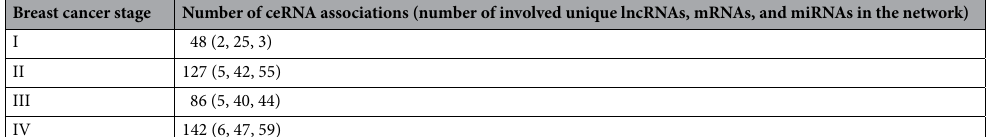
Table 2. The lncRNA-associated ceRNA networks for different breast cancer stages. lncRNA long-non-coding RNA, ceRNA competing endogenous RNA, mRNA messenger RNA , miRNA microRNA.